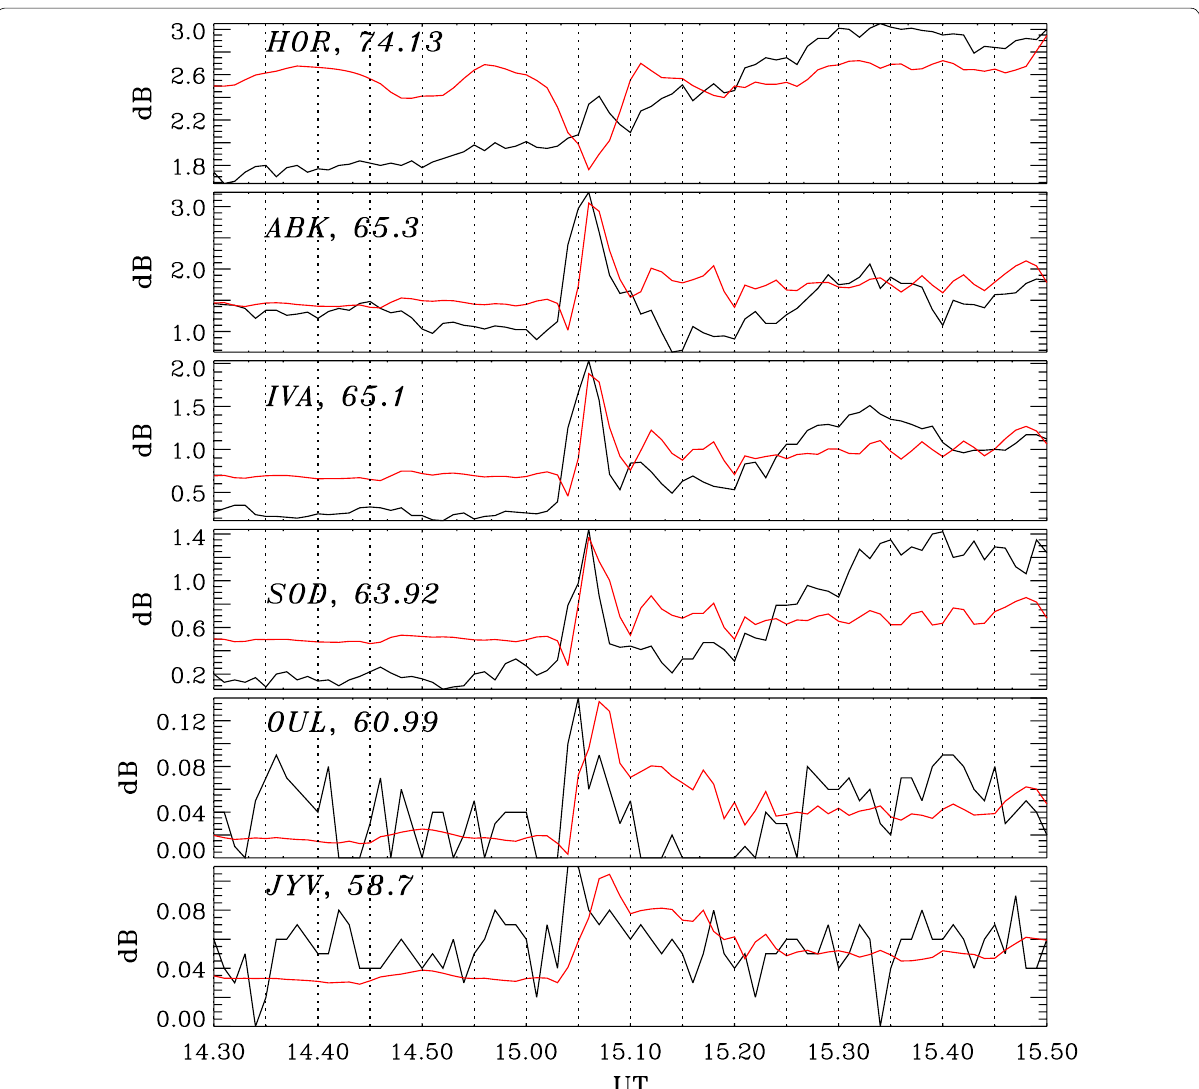
Fig. 8 Cosmic noise absorption ( black line ) and X-component magnetic field ( red line ) variation along the profile of stations HOR-ABK-IVA-SOD-OUL- JYV from the Finland riometer network and IMAGE array during 1450–1550